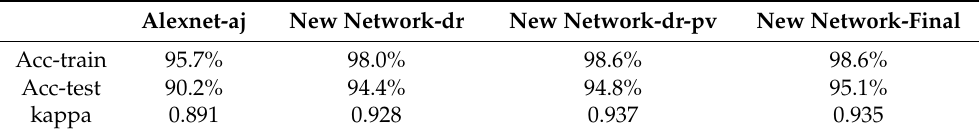
Figure 8. Accuracy curves of the constructed models. Table 5. Accuracy of the constructed